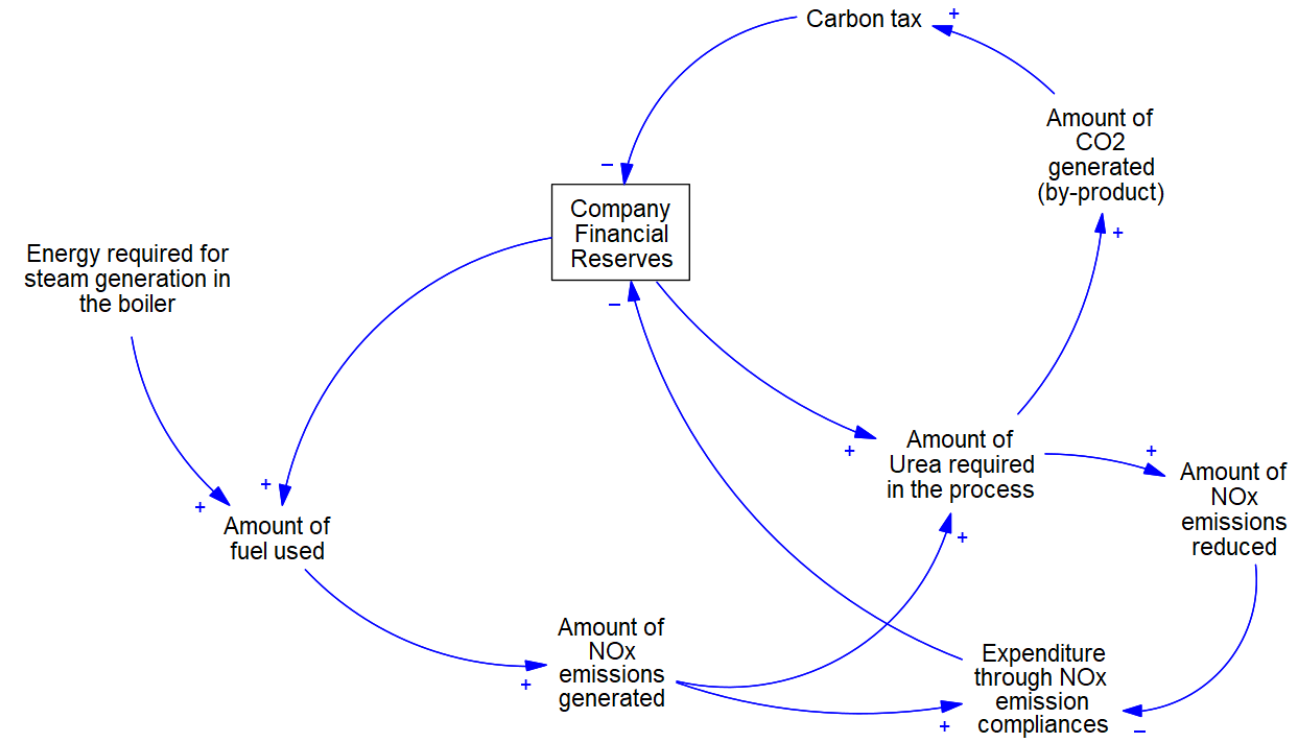
Figure 3. CLD of the Selective Non-Catalytic Reduction Module for NOx emission reduction.